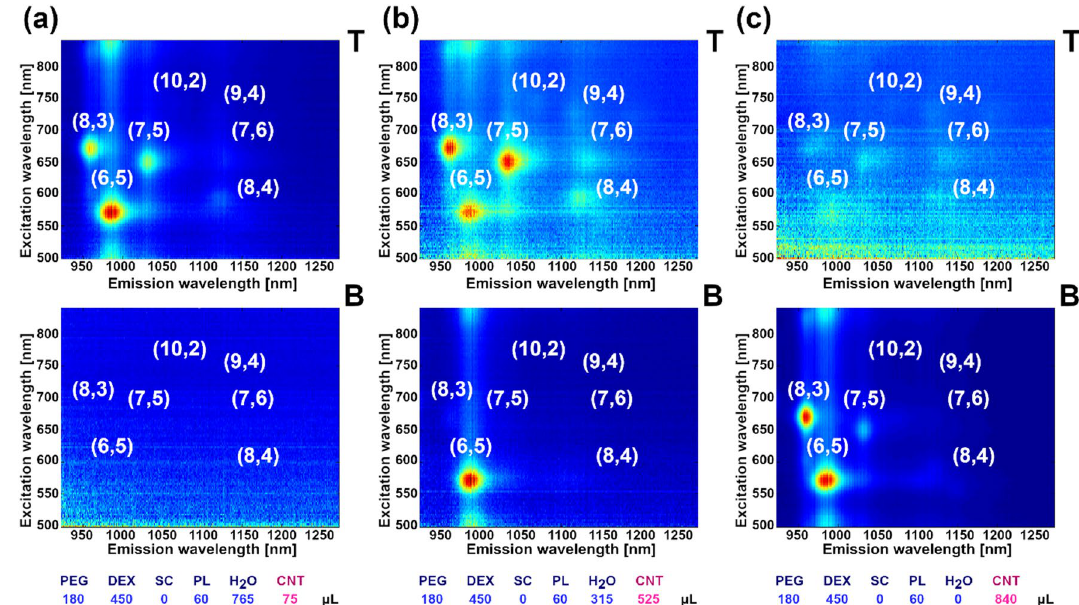
Figure 6. 2D PLE maps of SC-dispersed, (6,5)-enriched SWCNTs sorted by ATPE upon varying concentration of the SWCNT dispersion. Example volumes: ( a ) 75 µL, ( b ) 525 µL and ( c ) 840 µL. 2D PLE maps of remaining samples are shown in Supplementary Animation 8. Analogous data for unsorted SWCNT is presented in Fig. S7 and Supplementary Animation